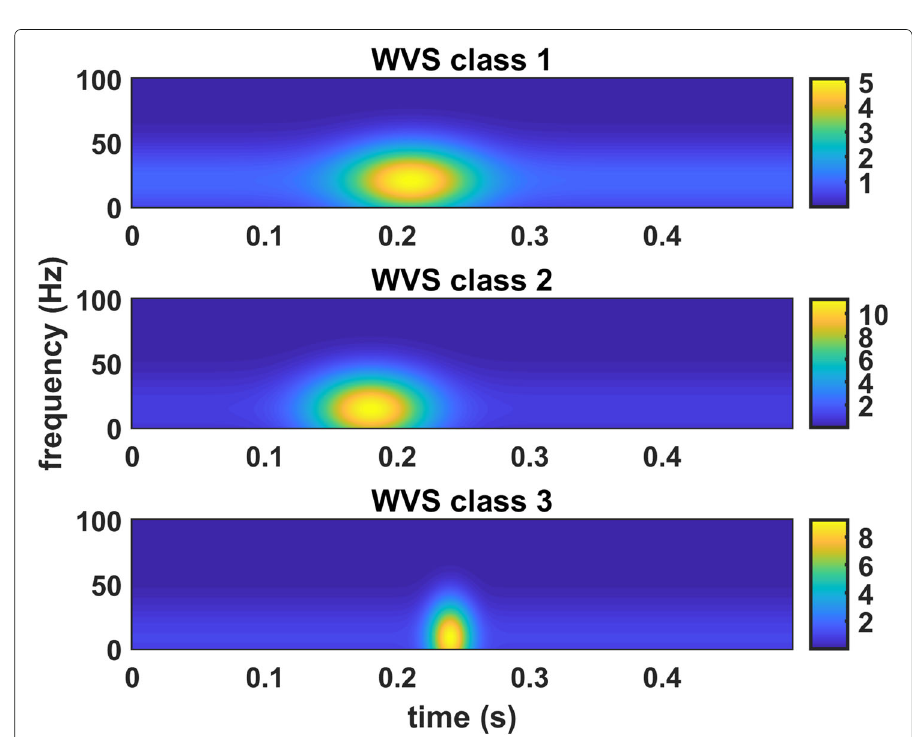
Fig. 8 True WVS for the three classes of simulated stochastic